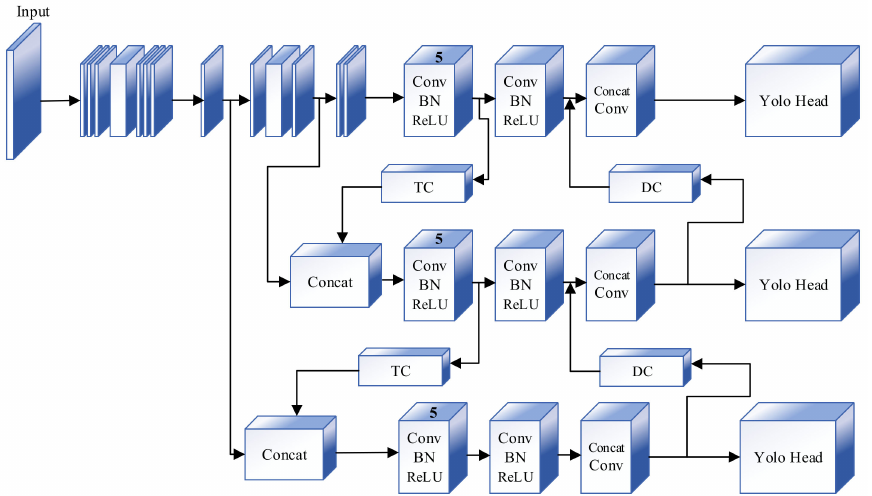
Figure 4. Disease target detection model